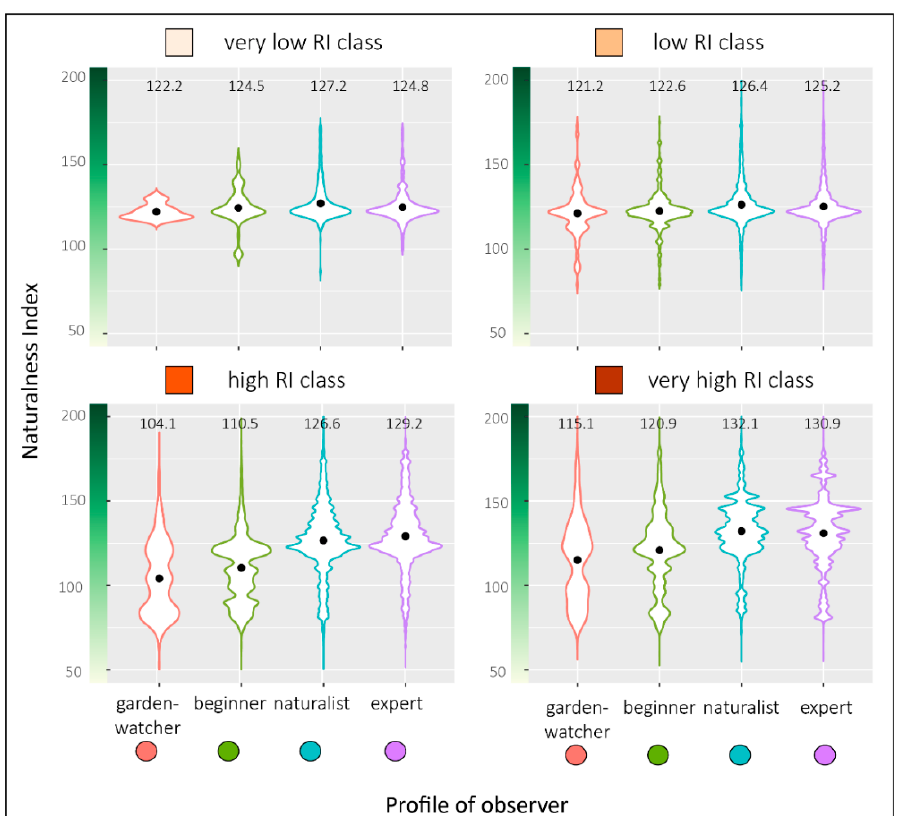
boundaries ( p = 0.05) and the central line is the initial sample mean.